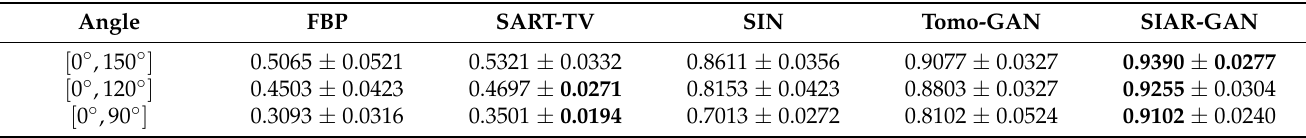
Table 2. Average SSIM results (mean ± standard deviation).